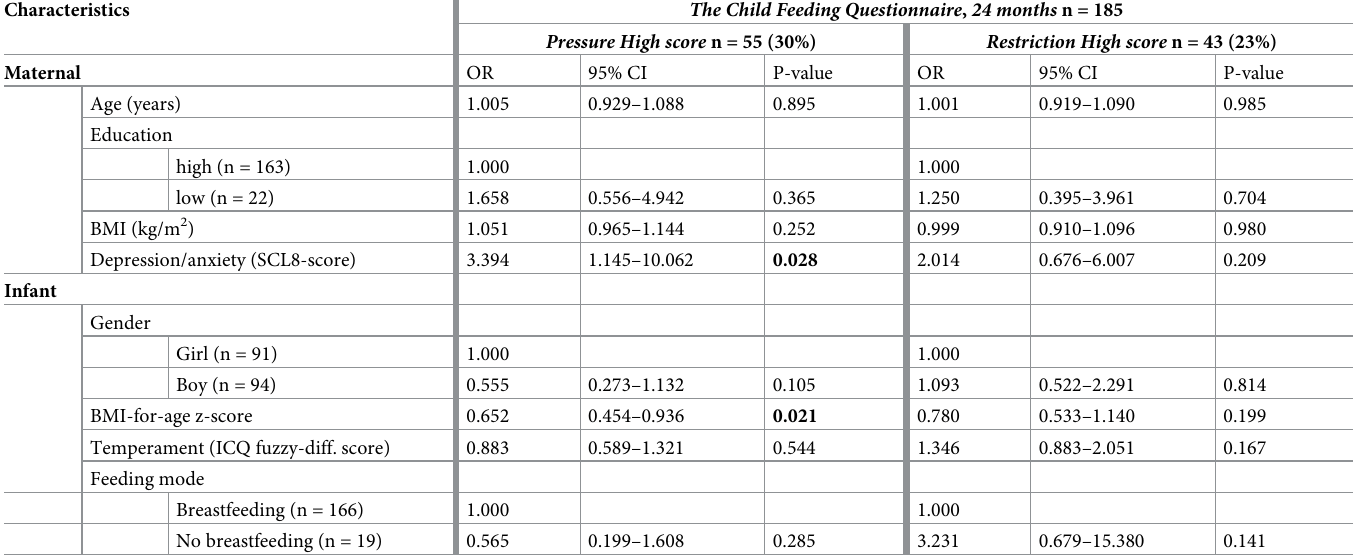
Table 4. Associations between maternal and child covariates at child age 5 months and maternal use of controlling feeding practices at child age 24 months esti- mated by multivariable logistic regression. Characteristics The Child Feeding Questionnaire , 24 months n =